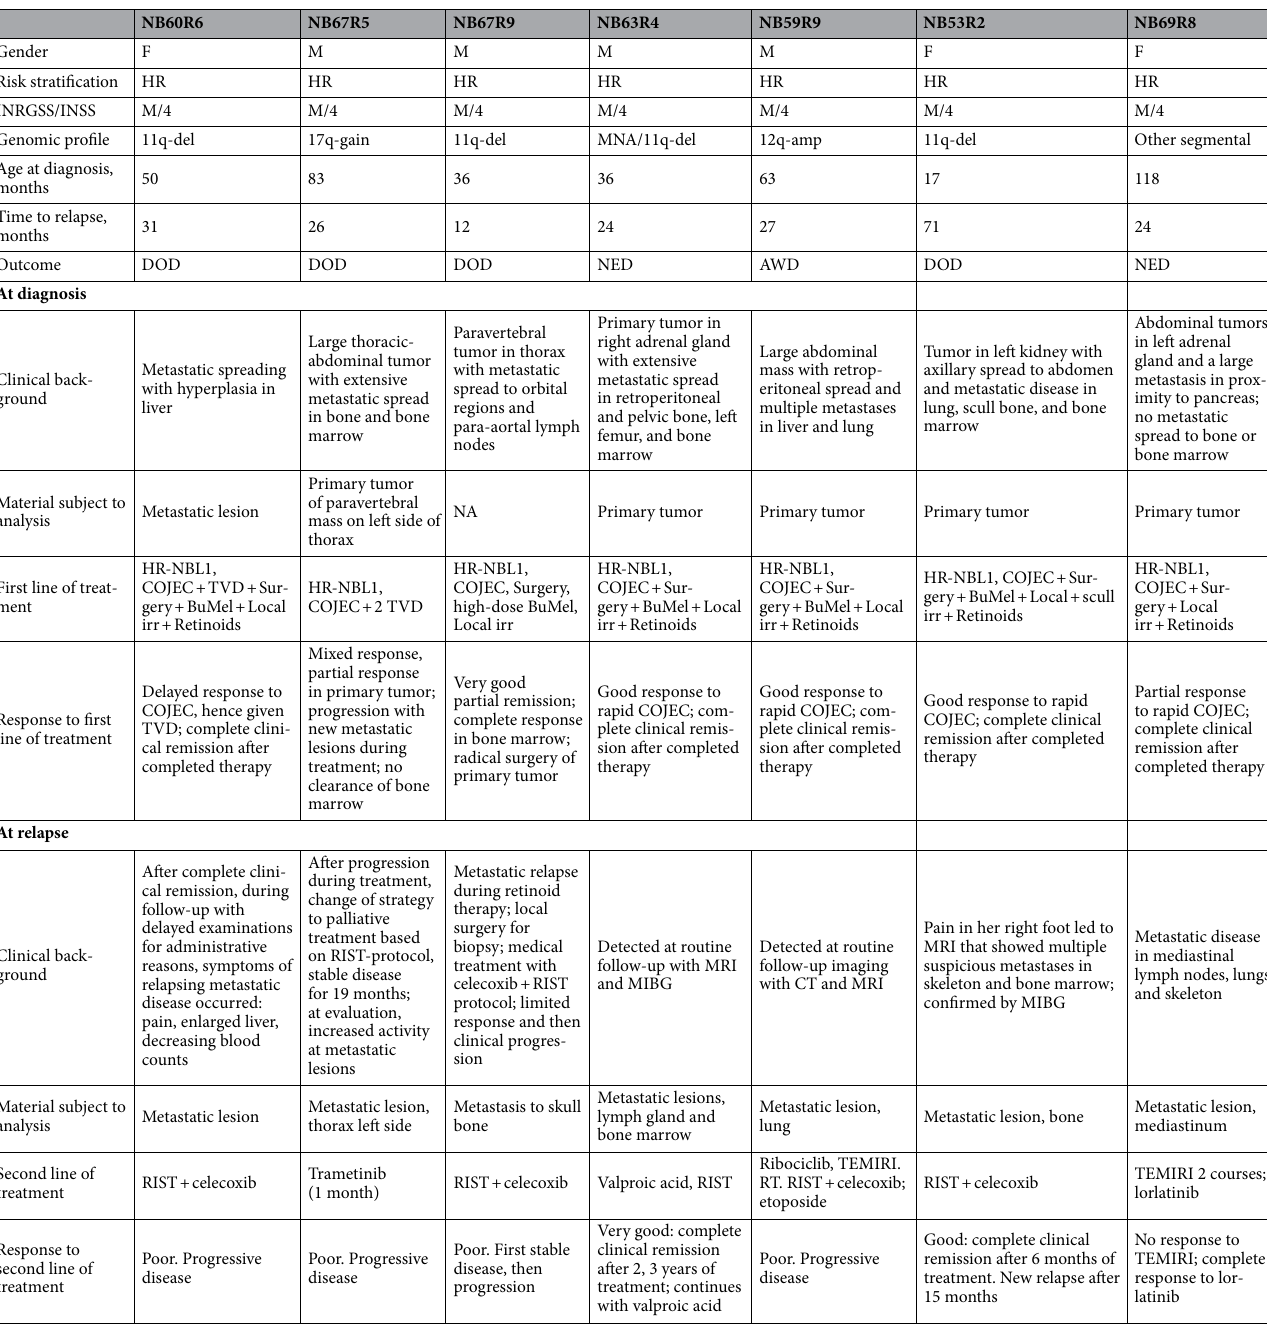
Table 1. Clinical characteristics of patients. F, female; M, male; INRGSS, International Neuroblastoma Risk Group Staging System; INSS, International Neuroblastoma Staging System; DOD, dead of disease; NED, no evidence of disease; AWD, alive with disease; MNA, MYCN-amplification; irr, irradiation; CR, complete remission according to INRC; COJEC, cisplatin [C], vincristine [O], carboplatin [J], etoposide [E], and cyclophosphamide [C]; BuMel, busulfan [Bu] and melphalan hydrochloride [Mel]; TVD, topotecan [T], vincristine [V], and doxorubicin [D]; RIST, rapamycin [R], irinotecan [I], dasatinib [S] and temozolomide [T]; TEMIRI, temozolomide [TEM] and irinotecan [IRI]; HR-NBL1 (NCT01704716, clinicaltrials.gov); NA, not